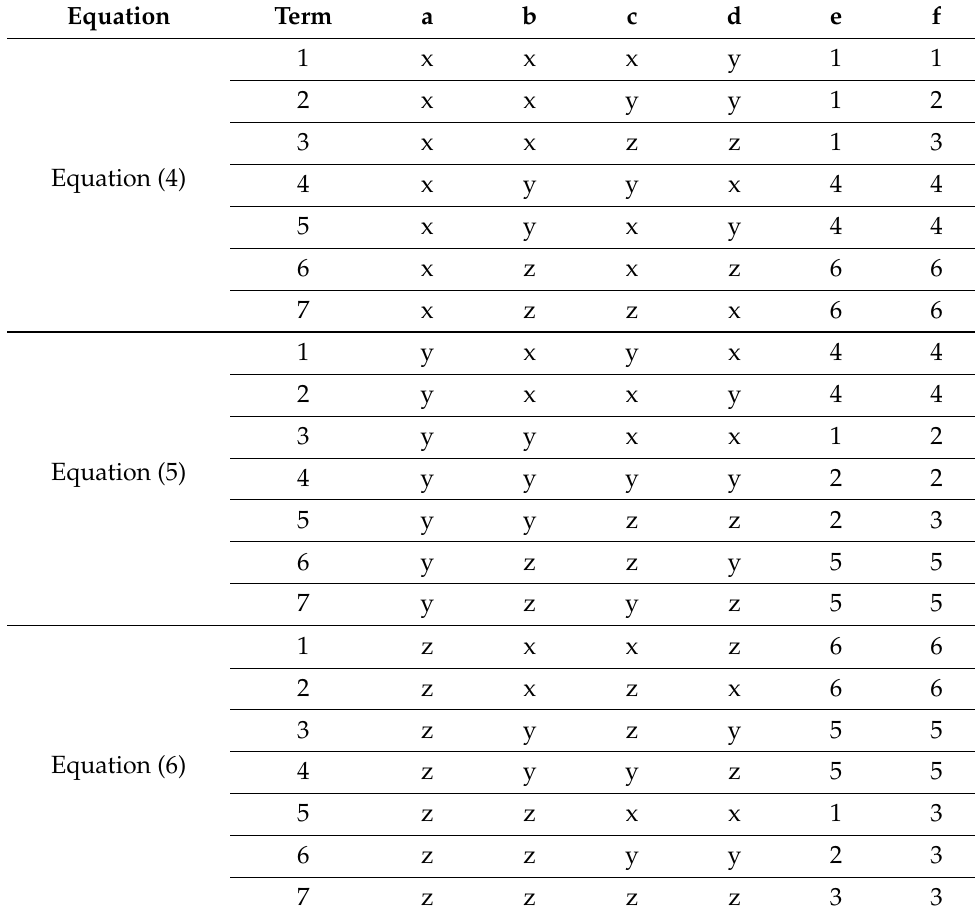
Table 1. The indices sets { S } used in Equation